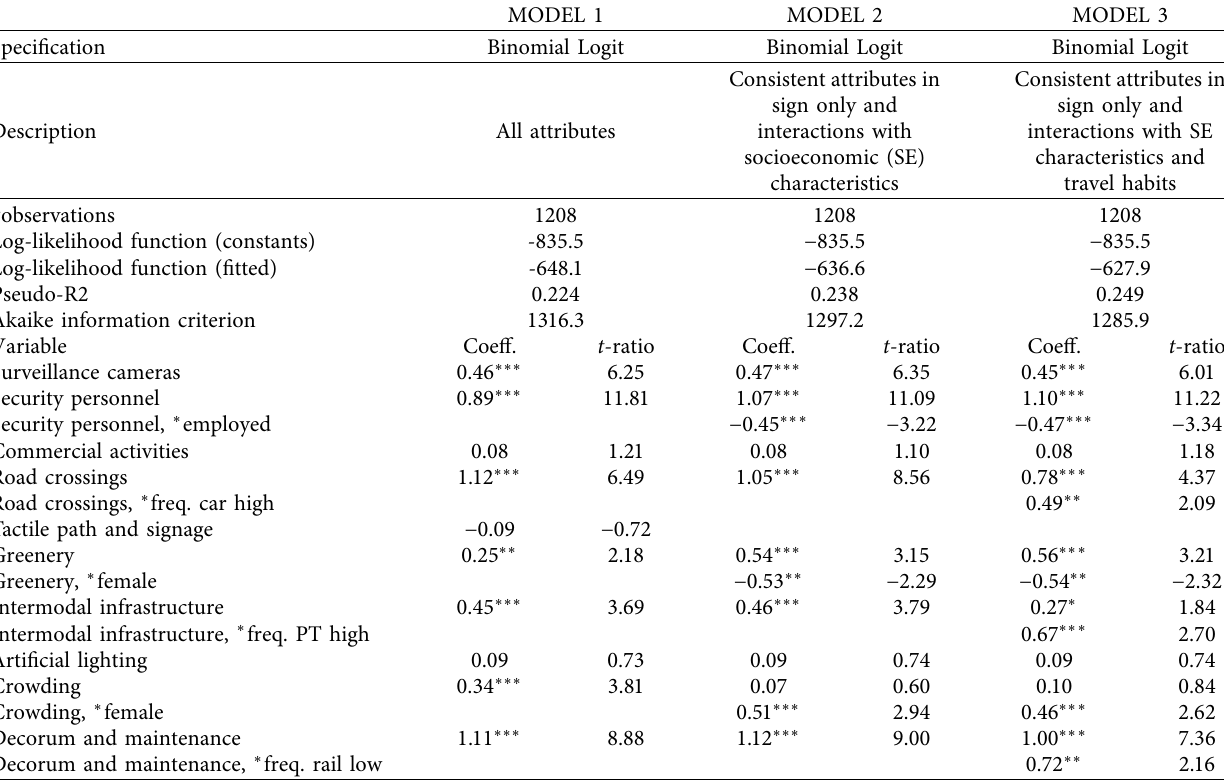
Table 3: Binomial Logit estimated